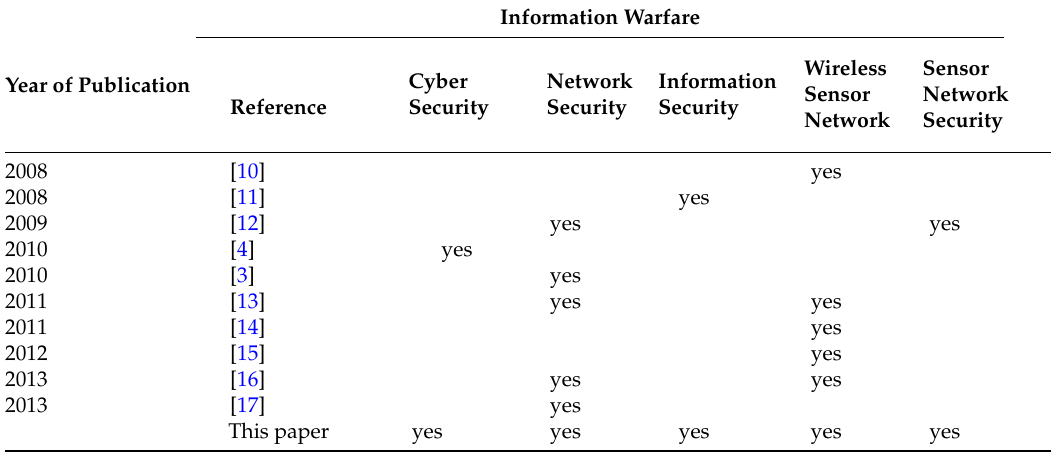
A summary of existing survey papers in the domain(s) of game theory and/or information